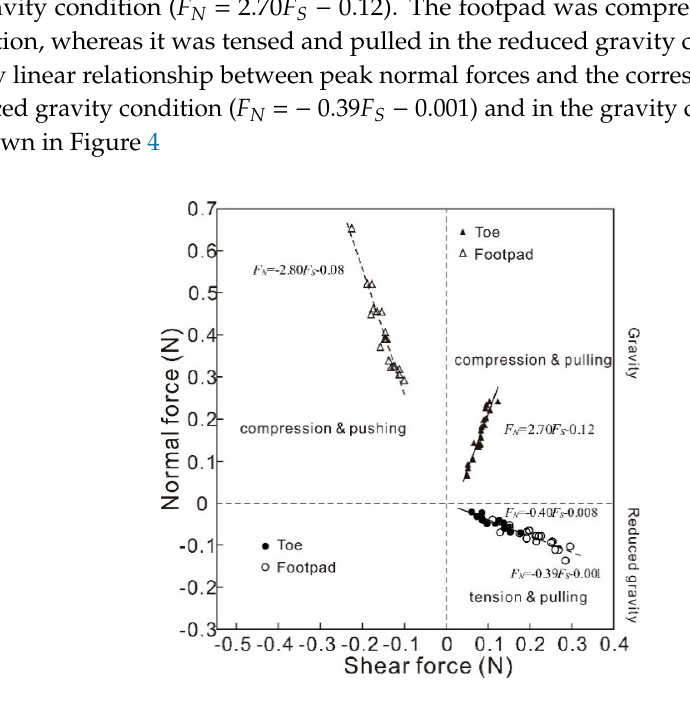
Figure 4. Relationship between the normal force and shear force of the single toe and single pad in the gravity condition and in the reduced gravity condition.